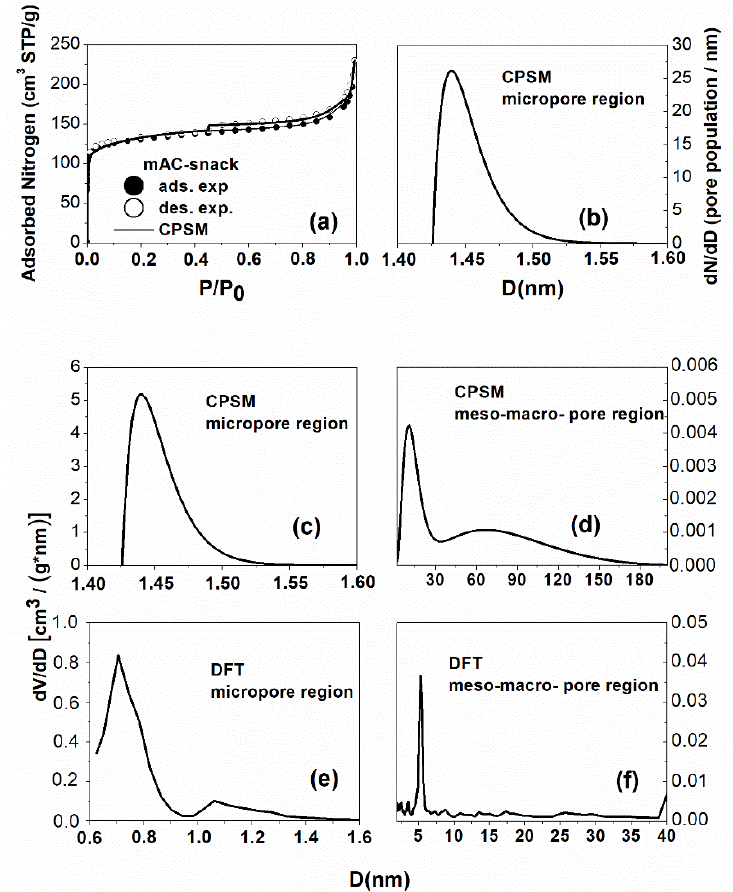
Figure 1. Nitrogen porosimetry results for the mAC-snack, ( a ) hysteresis loop CPSM simulation, ( b ) CPSM pore number (population) distribution, micropore region, ( c ) CPSM pore volume distribu- tion, micropore region, ( d ) CPSM pore volume distribution, meso- macro- pore region, ( e ) DFT pore volume distribution, micropore region, ( f ) DFT pore volume distribution, meso- macro- ropore region.